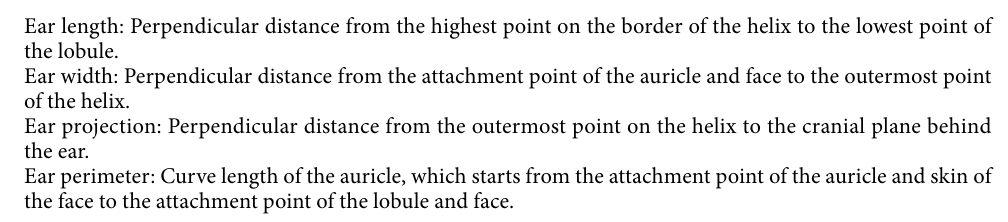
Figure 5. Scanning data were collected and synchronized into STL files by Artec Studio